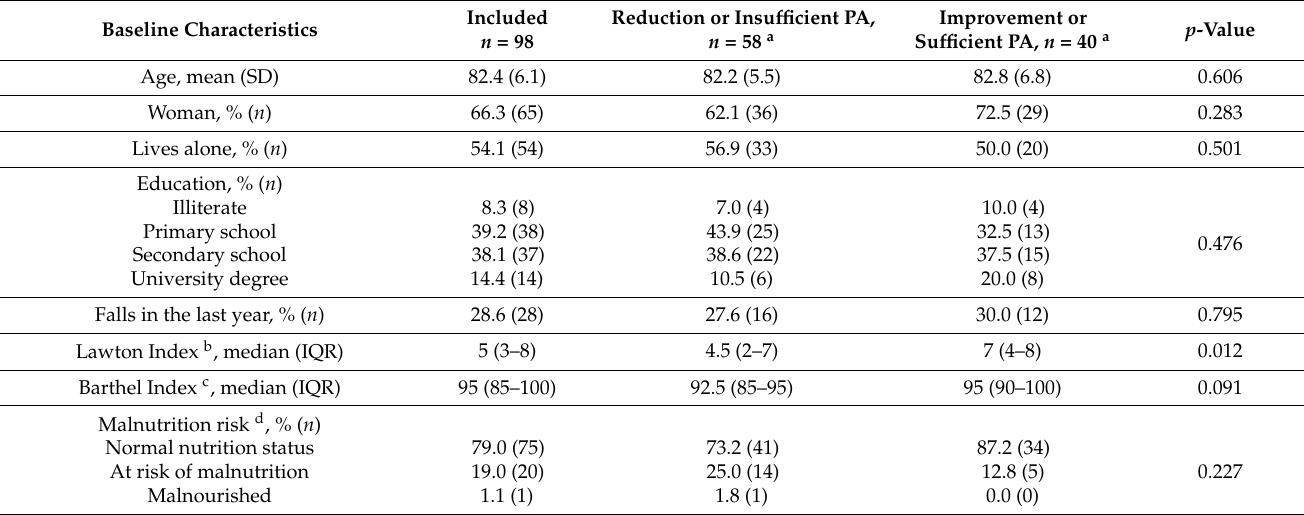
Table 1. Characteristics of the sample before the lockdown due to